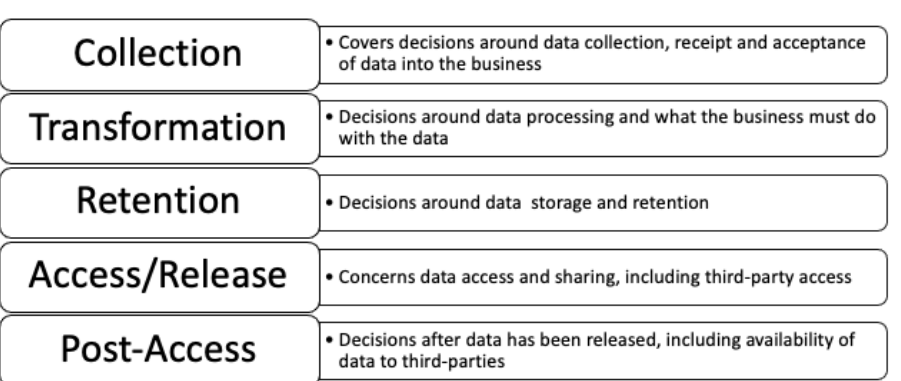
Figure 1. Adaptation of Altman’s data lifecycle for decision-making [5].